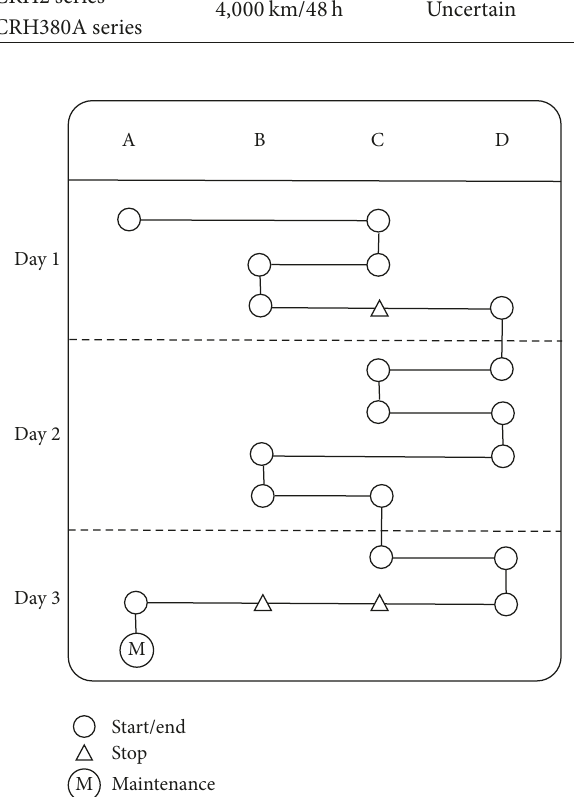
Figure 4: Utilization process of train-sets.